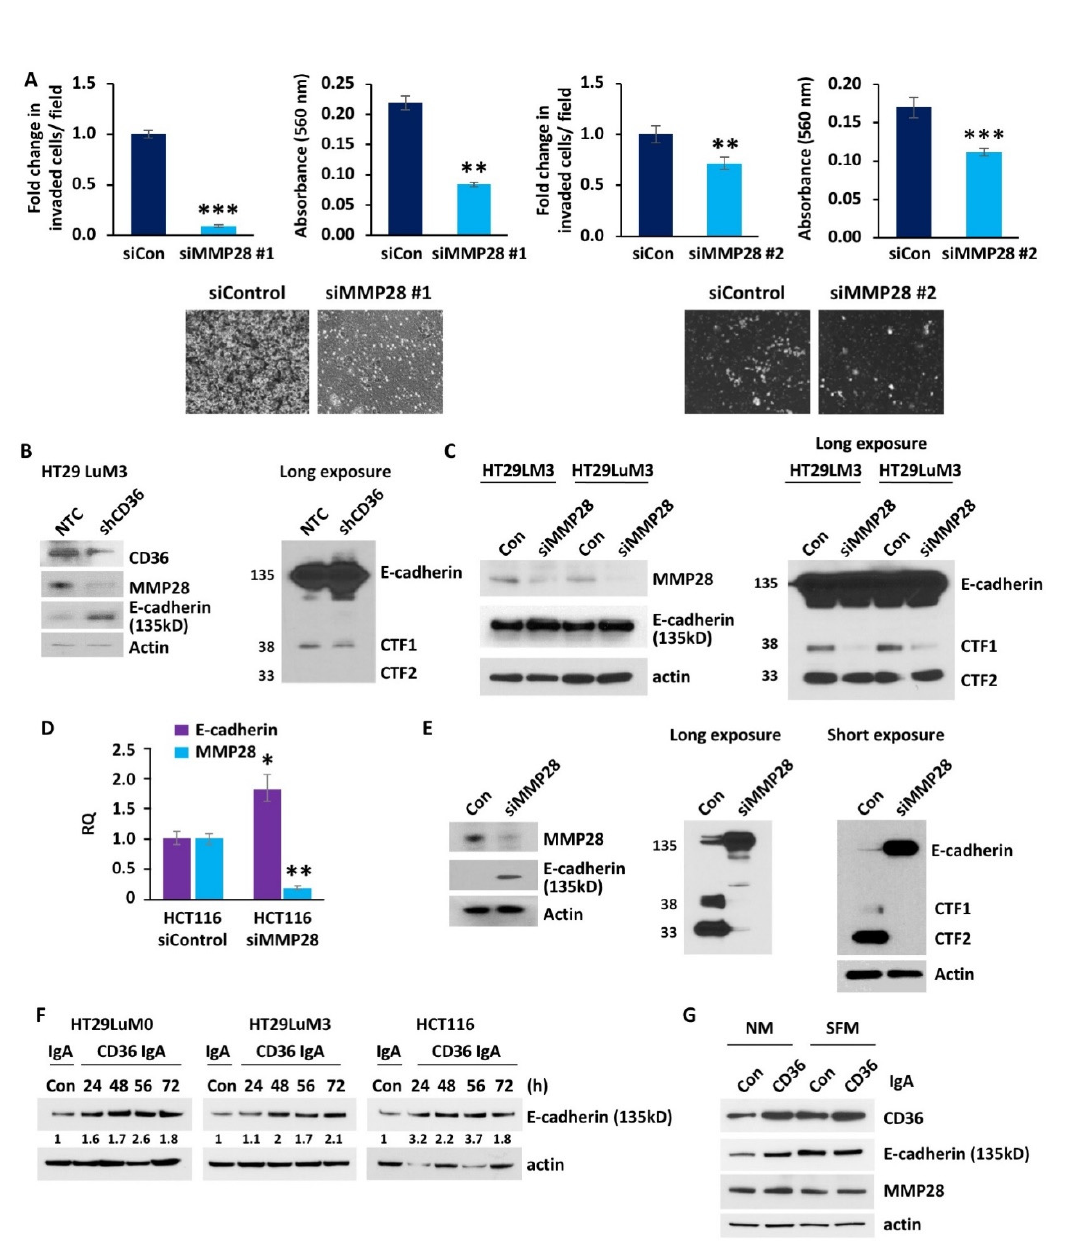
Figure 5. MMP28 reduces CRC cell invasion and decreases expression of functional E-cadherin in vitro. ( A ) Fold change in invaded cells/field, absorbance at 560 nm of the de-stained Matrigel trans-well invasion chambers and raw images of the Matrigel trans-well invasion chambers of the HCT116, siControl and siMMP28 cell lines ( n = 3). ( B ) Western blot analysis of the HT29 LuM3 NTC and shCD36 cell lines for CD36, MMP28 and E-cadherin. The long exposure of the same Western blot for E-cadherin is also shown. ( C ) Western blot for MMP28 and E-cadherin expression in HT29LM3 and HT29LuM3 cells. Western blot including the E-cadherin cleavage products CTF1 and CTF2 is shown on a separate blot (long exposure). ( D ) qRT-PCR analysis of the control and MMP28 siRNA transfected HCT116 cell lines for MMP28 and E-cadherin. ( E ) Western blot for MMP28 and E-cadherin expression in HCT116 cells. Western blot including the E-cadherin cleavage products CTF1 and CTF2 is shown on separate blots (long and short exposure). ( F ) Western blot analysis showing the effect of CD36 blocking antibody on E-cadherin expression in HT29 LuM0, HT29LuM3 and HCT116 cells. Expression of E-cadherin is quantified based on band intensity and normalized to actin. ( G ) Western blot analysis showing the effect of CD36 blocking antibody on e-cadherin and MMP28 expression in HCT116 cells treated with IgA or IgCD39 for 48 h in normal medium or SFM (* p < 0.05, ** p < 0.01, *** p < 0.001).